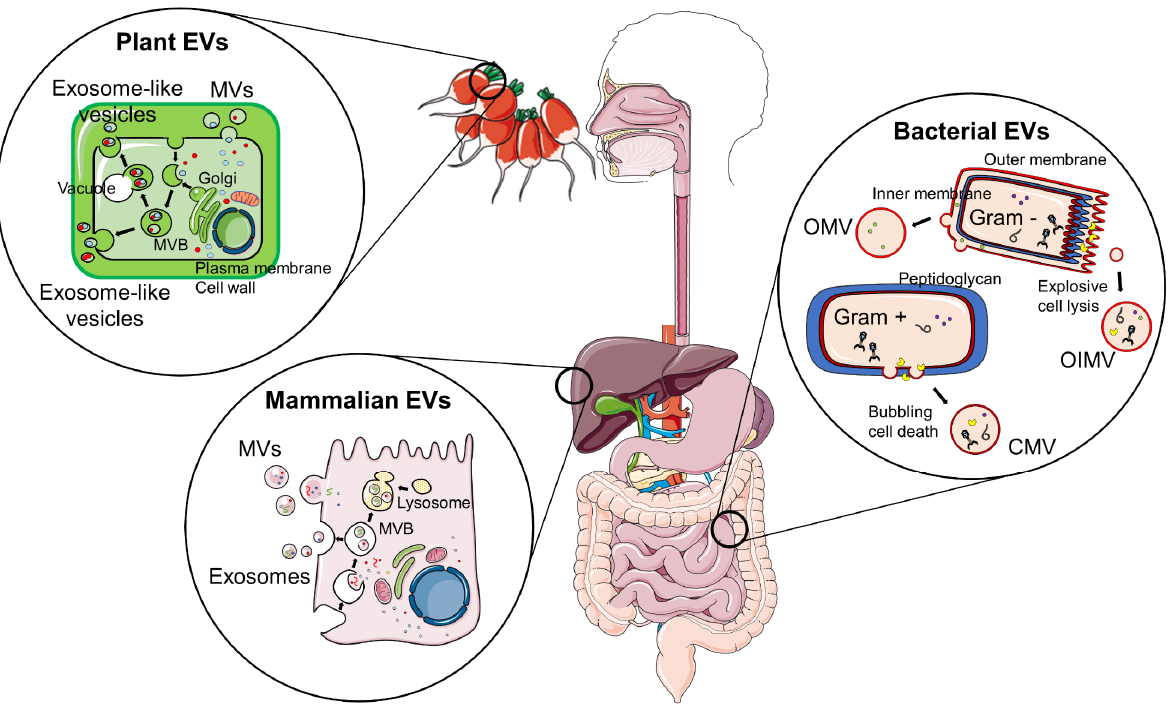
Figure 1. EV biogenesis in plants, mammals, and bacteria. Aside from apoptotic bodies generated upon programmed cell death, plant and mammalian cells release two main types of EVs: MVs resulting from plasma membrane evaginations and exosomes formed when the membrane of early endosomes invaginates in the intracellular space, engulfing a portion of the cytoplasm and giving rise to a multivesicular body (MVB) that may then fuse with lysosomes to recycle cellular components or with the plasma membrane, hence releasing the exosomes to the extracellular space. Alternatively, Gram ‐ negative bacteria have two routes for bEV formation: blebbing of the outer membrane caused by cell cover disturbances leads to the production of OMVs that do not contain cytoplasmic components, whereas explosive cell lysis initiated by phage ‐ derived endolysin that degrades the peptidoglycan cell wall results in cells bursting and releasing membrane fragments that self ‐ assemble into OIMVs, which contain cytoplasmic components. In Gram ‐ positive bacteria, endolysin triggers bubbling cell death, which is induced by DNA ‐ damaging stress and results in CMVs that contain membrane and cytoplasmic components.